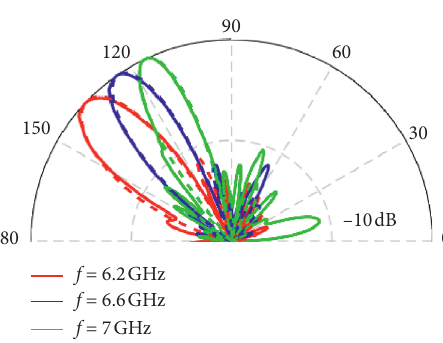
Figure 17: The measured radiation pattern of the proposed pe- riodic MLWA in the backward (—— measured ---- simulated).